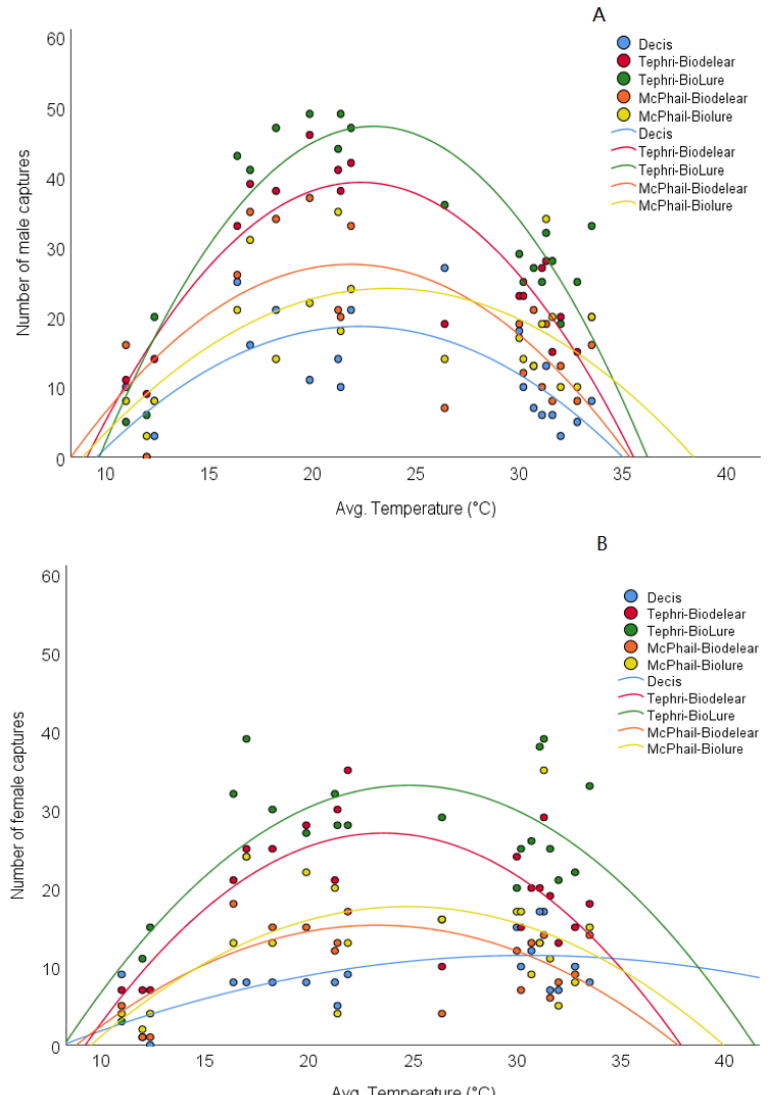
Figure 2. Relationship between male ( A ) and female ( B ) captures and average temperatures. For males (A) Decis ® : y = −0.12x 2 + 5.16x − 38.8, R 2 = 0.448, p = 0.006; Tephri-Biodelear: y = −0.23x 2 + 10.05x − 72.95, R 2 = 0.71, p < 0.001; Tephri-BioLure: y = −0.27x 2 + 12.38x − 94.85, R 2 = 0.777, p < 0.001; IPMT-Biodelear: y = −0.15x 2 + 6.6x − 44.56, R 2 = 0.435, p = 0.008 and IPMT-BioLure: y = −0.11x 2 + 5.24x − 37.9, R 2 = 0.333, p = 0.032. For females (B) Decis ® : y = −0.02x 2 + 1.39x − 9.84, R 2 = 0.398, p = 0.013; Tephri-Biodelear: y = −0.13x 2 + 6.21x − 46.17, R 2 = 0.526, p = 0.002; Tephri-BioLure: y = −0.12x 2 + 5.97x − 41, R 2 = 0.484, p = 0.004; IPMT-Biodelear: y = −0.07x 2 + 3.4x − 24.32, R 2 = 0.293, p = 0.052, and IPMT-BioLure: y = −0.08x 2 + 3.77x − 29.02, R 2 = 0.398, p = 0.097.